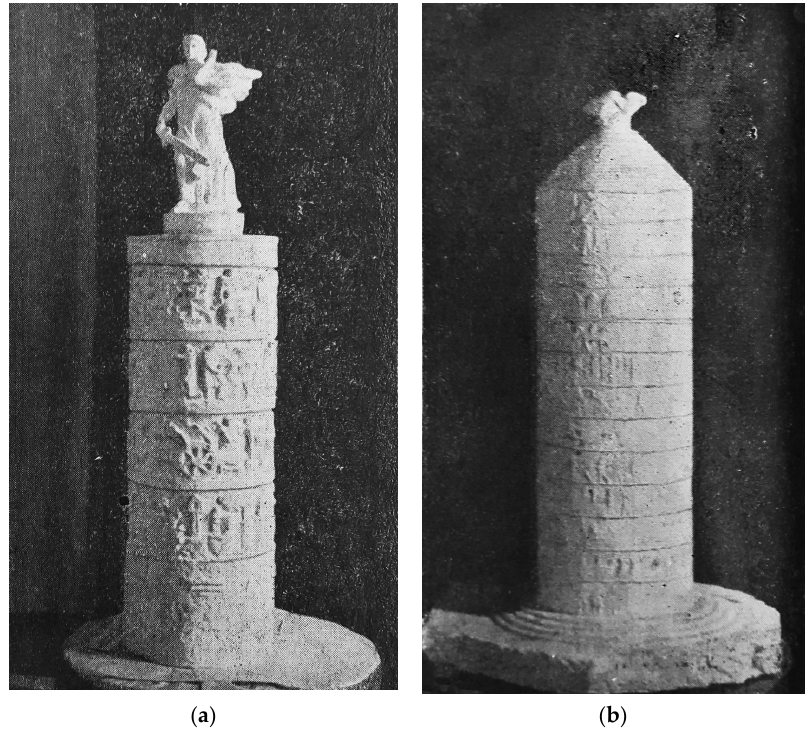
Figure 3. Saint Anne Mountain, the first competition for the design of the monument commemorating the Silesian Insurgents; parts of models made by: ( a ) Marian Wnuk, ( b ) Stefan Momot and Józef Trenarowski (Frydecki and Michejda 1946, p. 6).